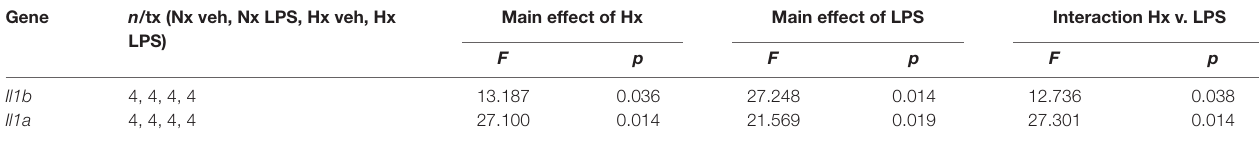
TABLE 5 | Two-way ANOVA results for Hx priming 3-days post-Hx. Gene